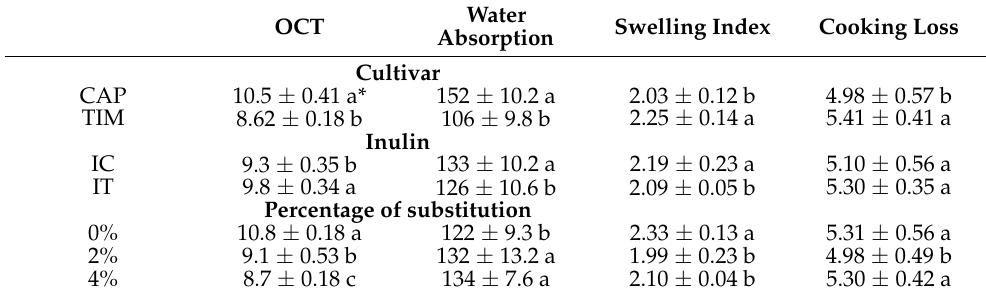
Table 5. Cooking quality of spaghetti (mean ± SD, n =